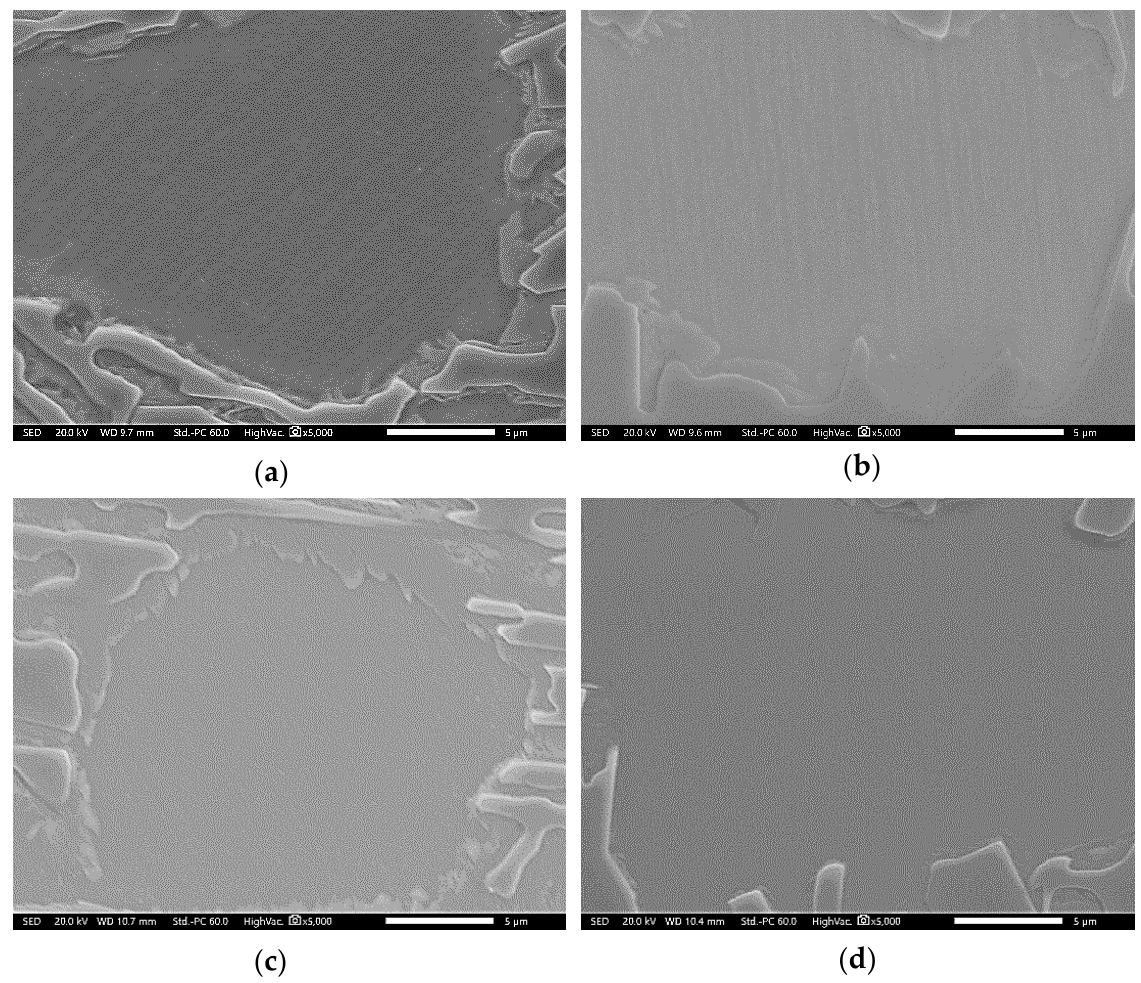
Figure 2. Optical micrographs of the as-cast alloys showing various dendrite fractions: ( a ) 2124; ( b ) 2127; ( c ) 2427; ( d ) 2827; ( e ) 2927.